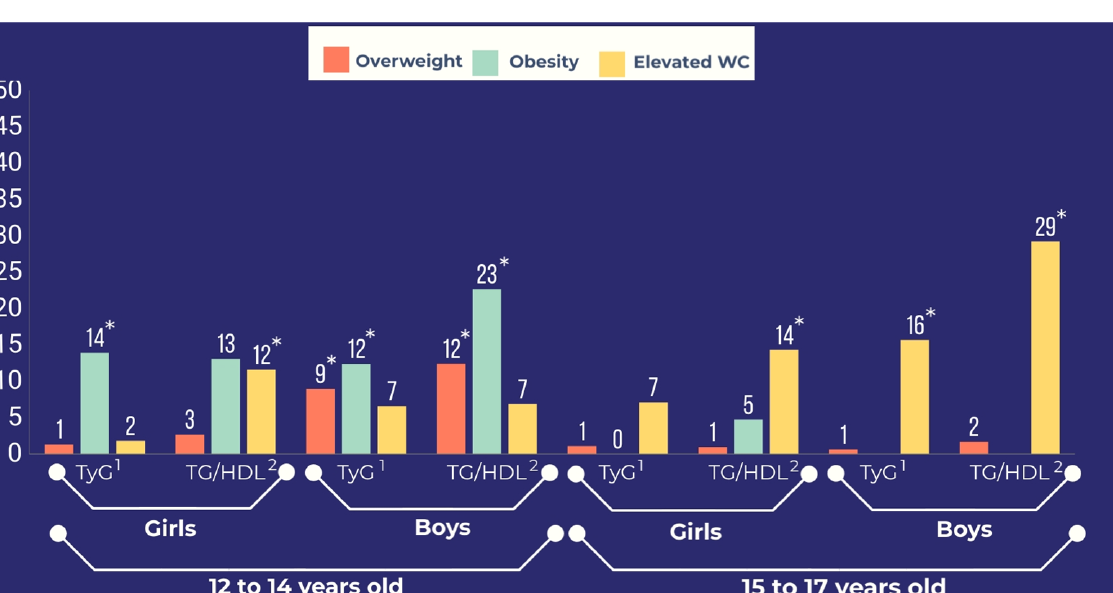
The FIeq for overweight tended toward the null for TyG and TG/HDL, except for boys aged 12 to 14 years (Figure